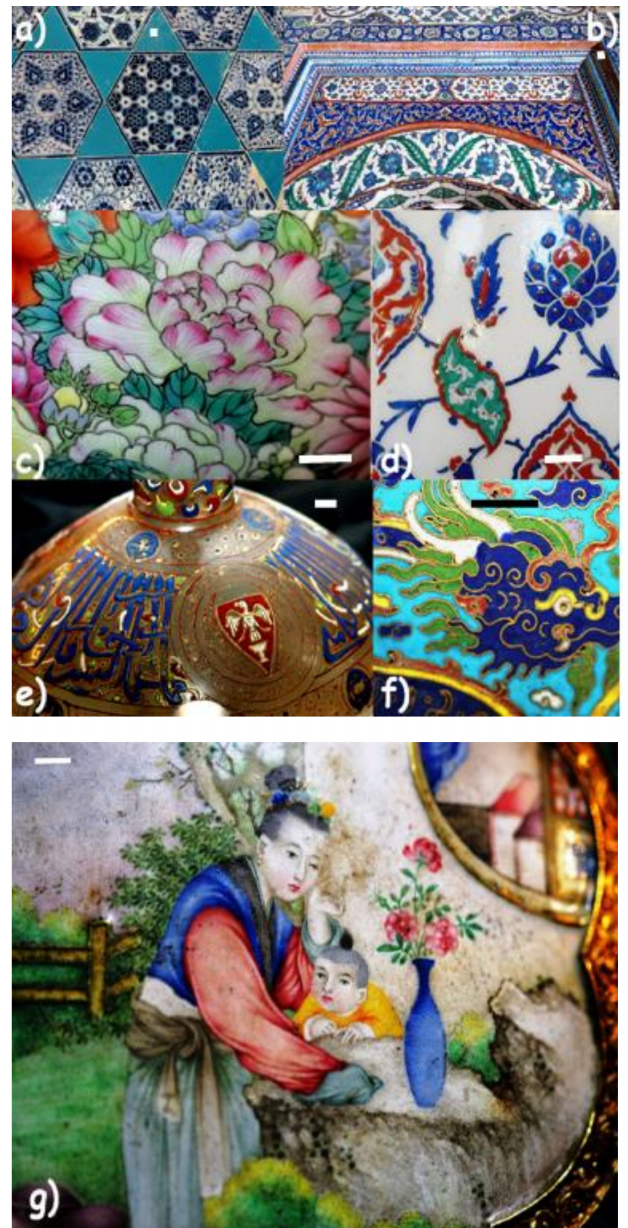
Figure 2. Examples of the variety and complexity of enamelled decorations: ( a ) blue-and-white